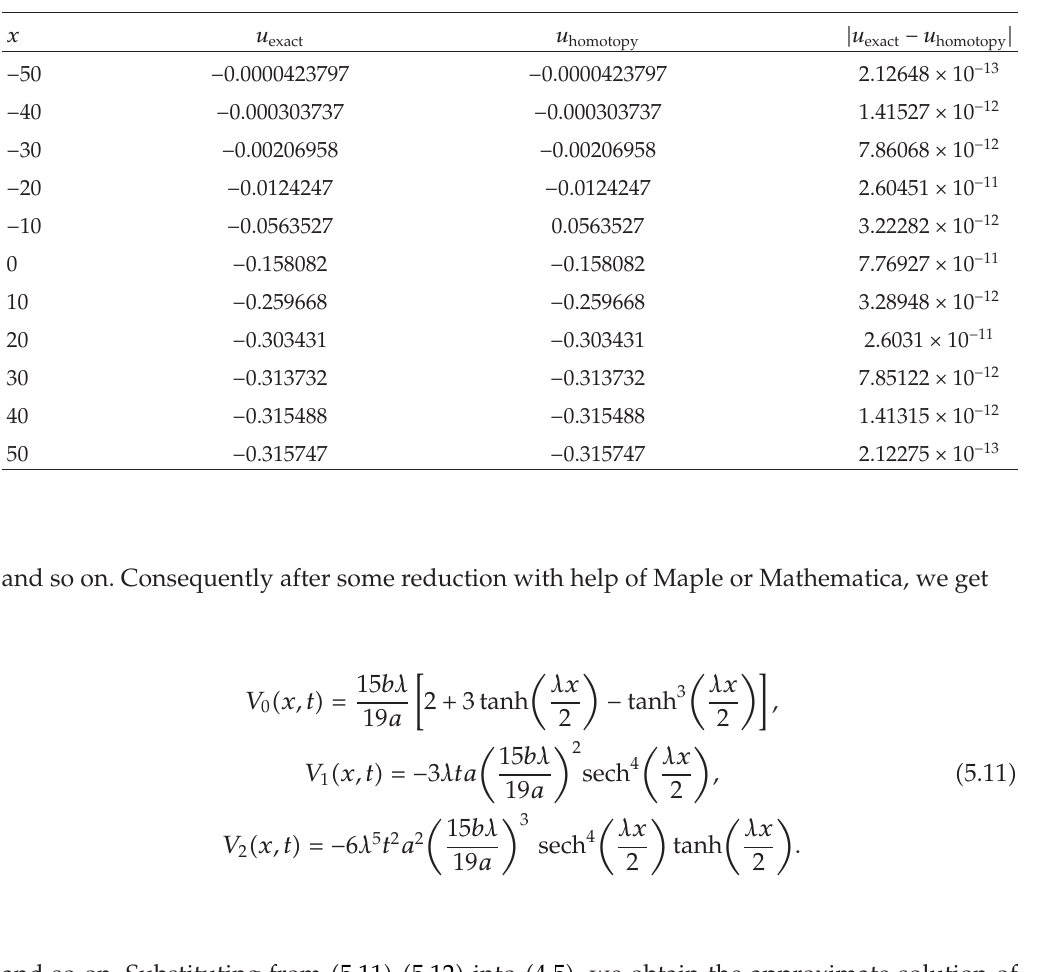
Table 2: The approximate solution (cid:2) 5.12 (cid:3) in comparison with the exact solution (cid:2) 5.8 (cid:3) if b (cid:7) − 1 , a (cid:7) 1 , λ (cid:7) 0 . 1 , and t (cid:7) 0 .